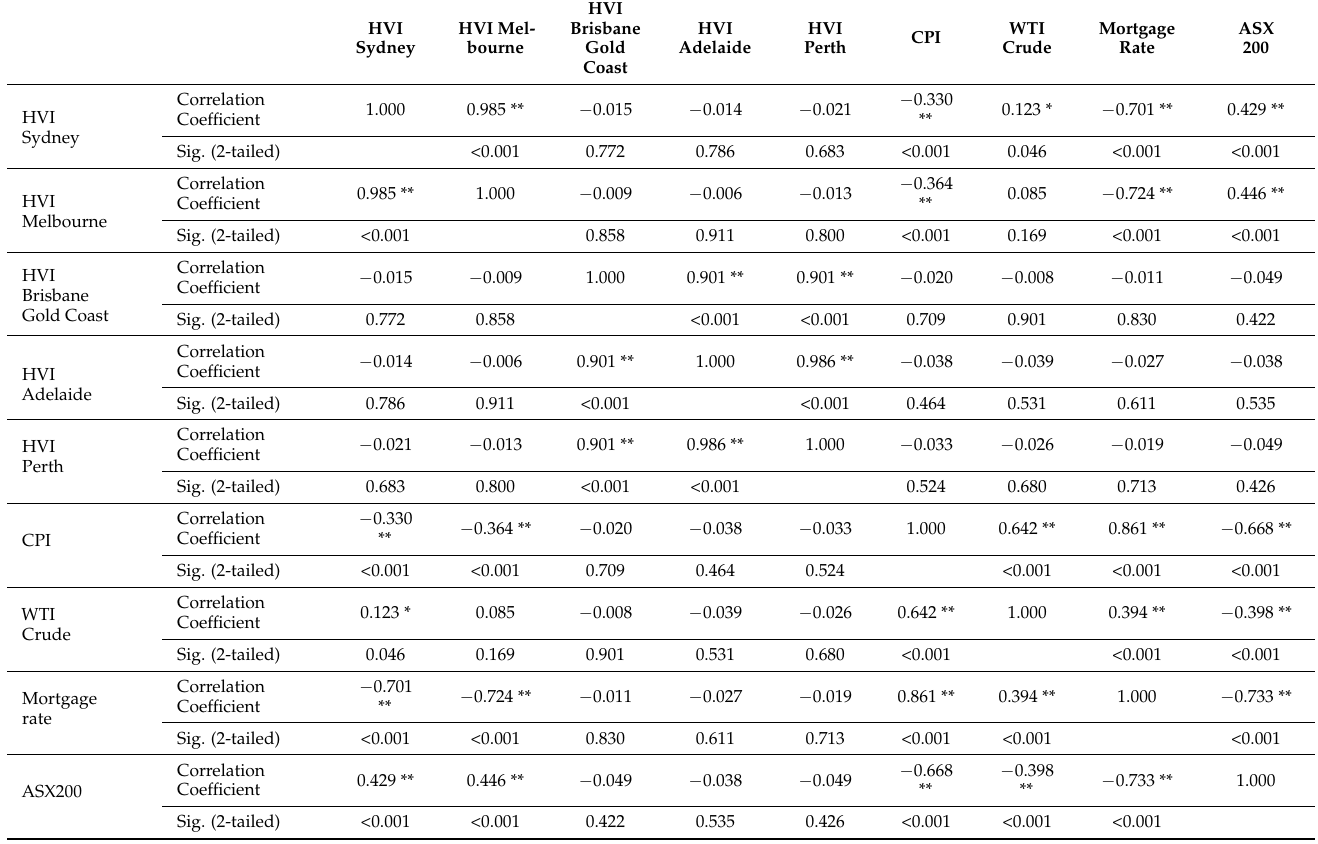
Table 1. Spearman’s rho correlation